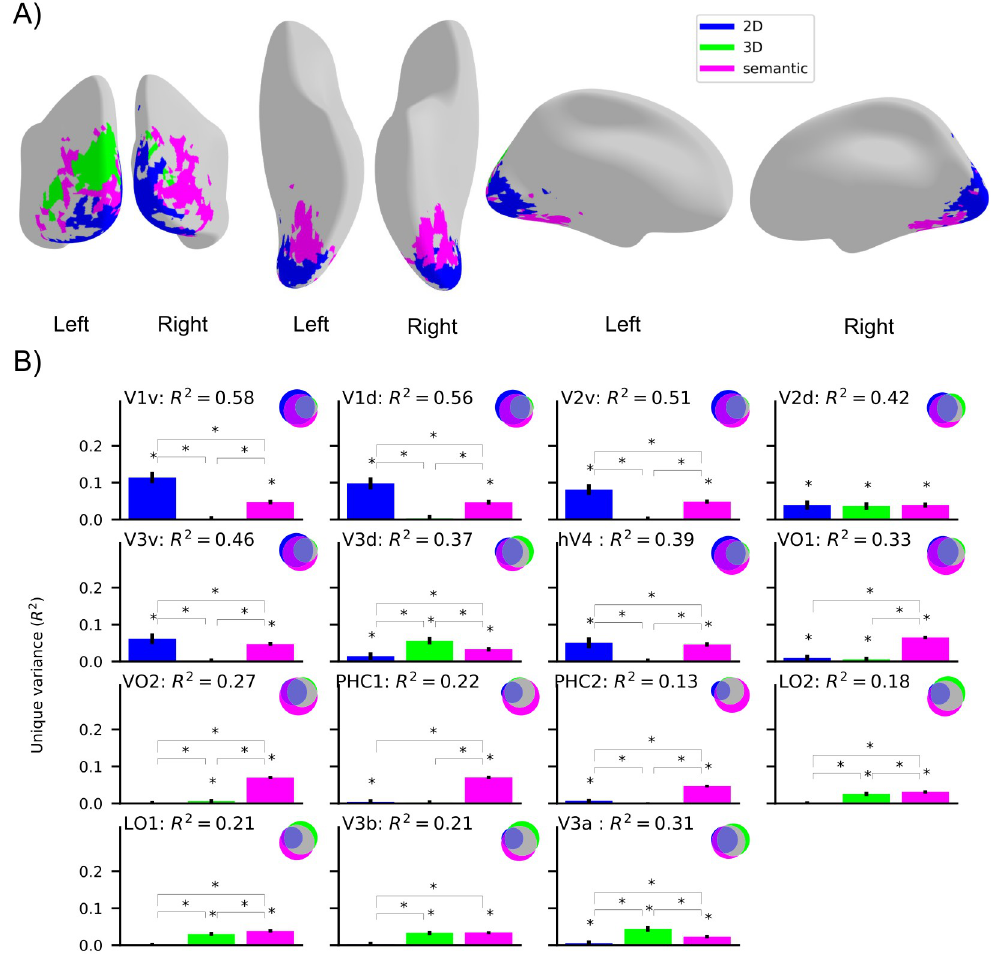
Fig 3. Functional mapping of the visual cortex with respect to 2D, 3D, and semantic tasks. A) Functional map of the visual cortex showing the regions where unique variance explained by one DNN group (2D, 3D, or semantic) is significantly higher than the variance explained by the other two DNN groups (p < 0.05, permutation test with 10,000 iterations, FDR- corrected). We show the results for the voxels with a significant noise ceiling that show significantly higher unique variance for one DNN group than other two DNN groups (p < 0.05, permutation test with 10,000 iterations, FDR-corrected across DNNs and searchlights). The functional brain map can be visualized in this weblink (https://sites.google.com/view/ dnn2brainfunction/home#h.xi402x2hr0p3). B) Absolute variance (R 2 ) explained in 15 ROIs by using 3 DNN RDMs averaged across task groups (2D, 3D, or semantic). The Venn diagram for each ROI illustrates the unique and shared variance of the ROI responses explained by the combination of 3 task groups. The bar plot shows the unique variance of each ROI explained by each task group individually. The asterisk denotes whether the unique variance or the difference in unique variance was significant (p < 0.05, permutation test with 10,000 iterations, FDR-corrected across DNNs). The error bars show the standard deviation calculated by bootstrapping 90% of the conditions (10,000 iterations).